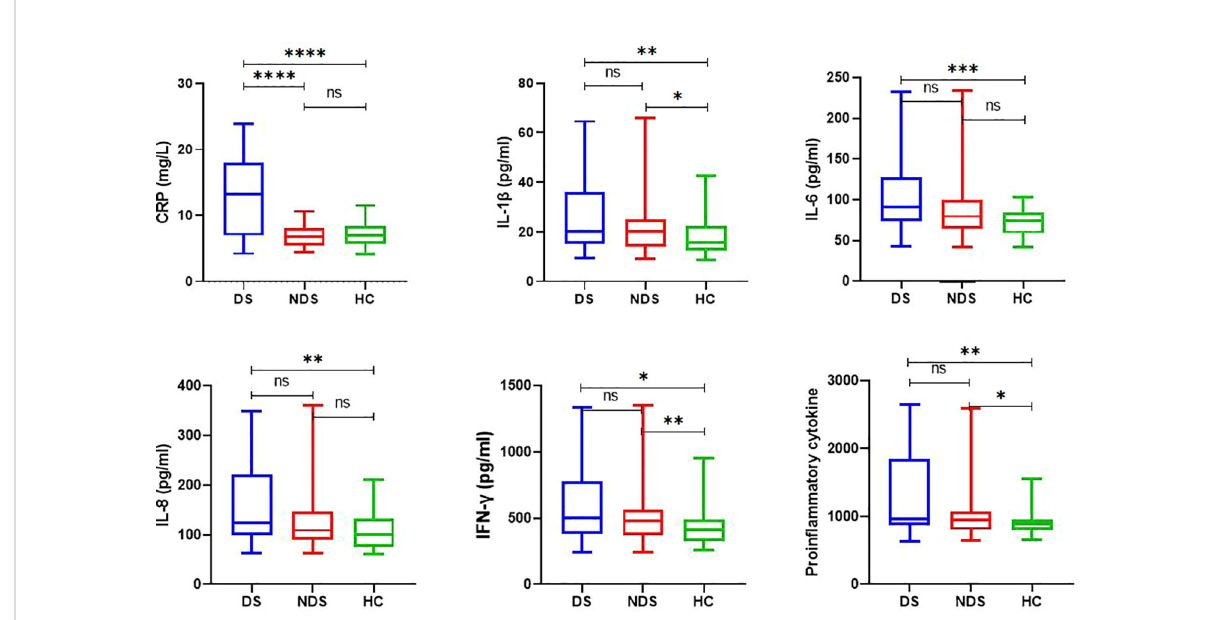
FIGURE 1 Plasma levels of in fl ammatory cytokines in control subjects, de fi cit and nonde fi cit schizophrenia patients. Each bar represents the median level of cytokines. Error bars represent the interquartile. DS, De fi cit schizophrenia; NDS, Nonde fi cit schizophrenia; HC, Healthy controls. (*p < 0.05, **p < 0.001, ***p < 0.0005, ****p < 0.0001). ns =No statistical difference.